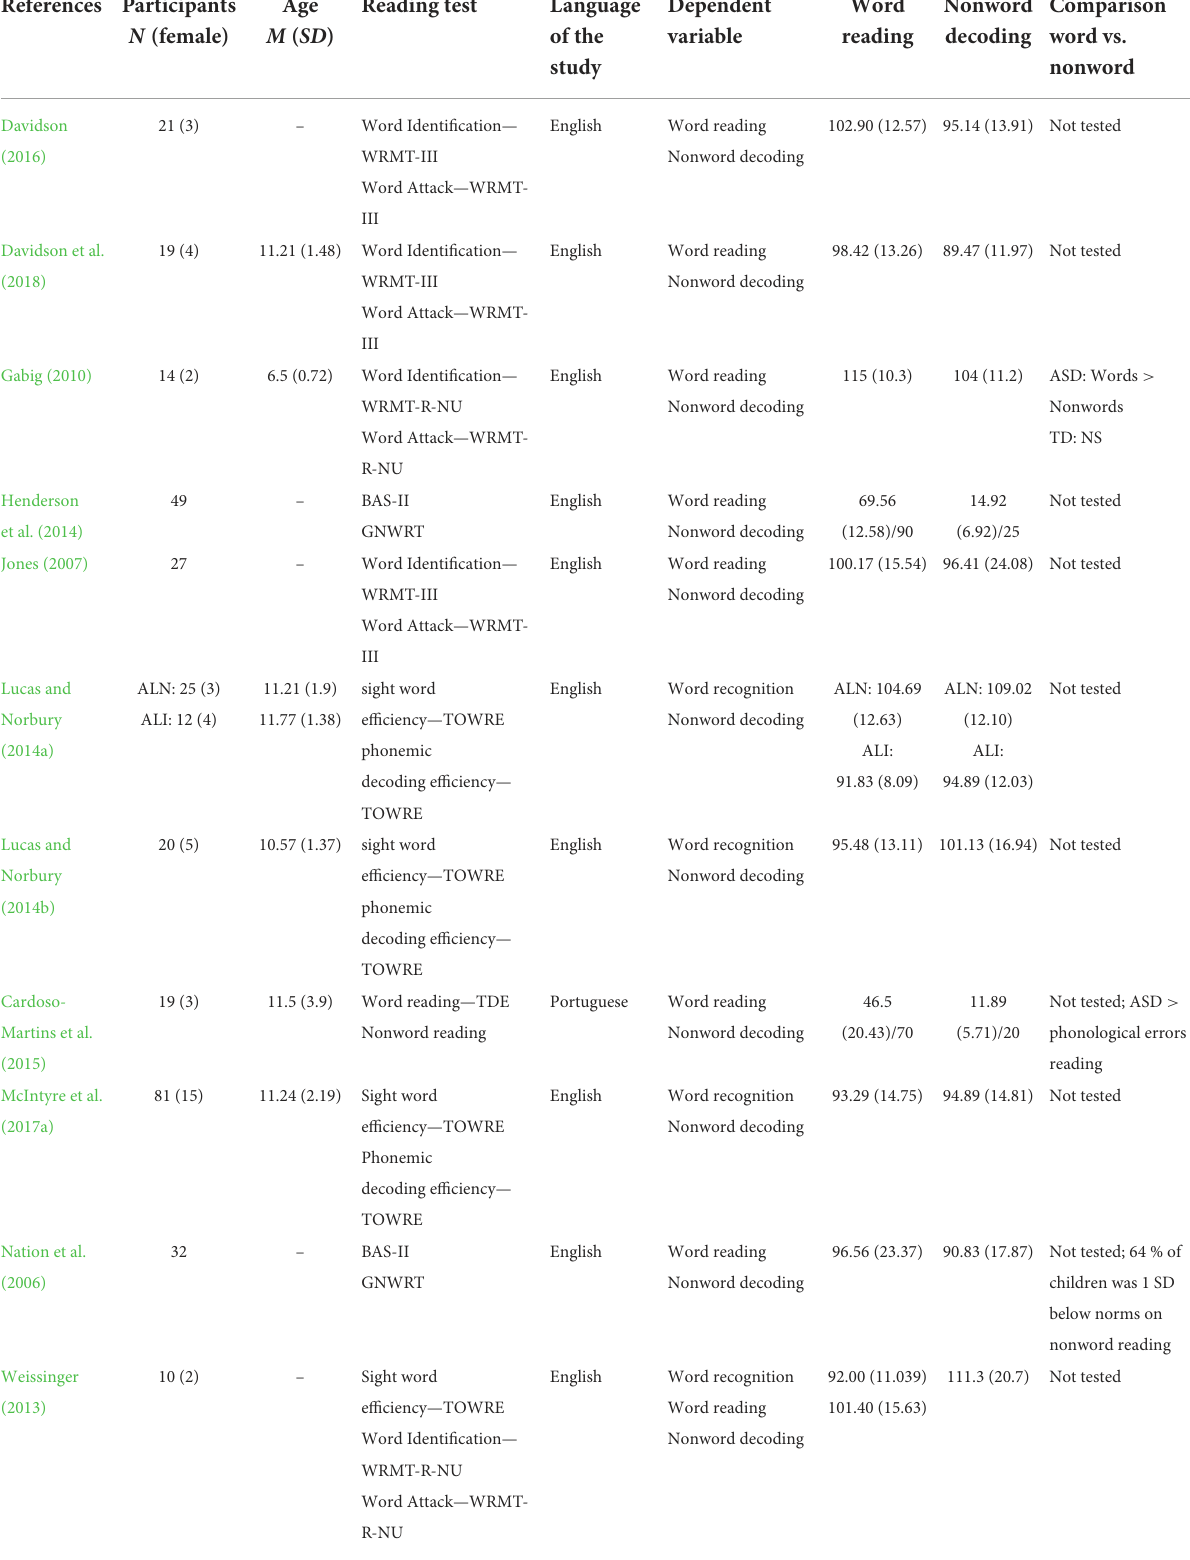
TABLE 4 Results of the studies that compared the performance of children with ASD in tests assessing word and nonword reading. References